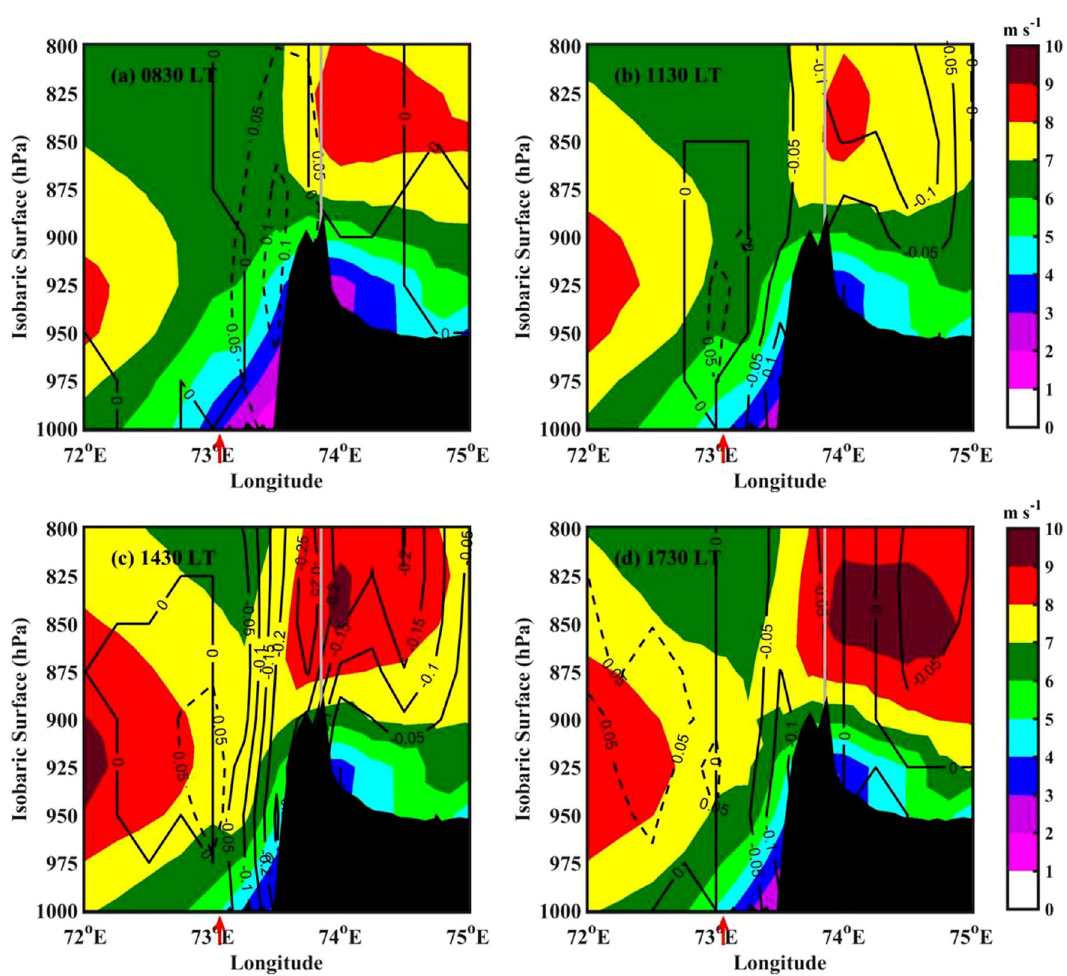
Figure 5. The mean wind speed (colour-filled contours) and vertical velocity (in pressure coordinate) deviation ◦ from the mean (black contours) along 18 N during ( a ) 0830 LT, ( b ) 1130 LT, ( c ) 1430 LT, and ( d ) 1730 LT. The solid contours represent negative vertical velocity (upward motion), and dashed contours represent positive vertical velocity (downward motion). The coastline is indicated with a red colour arrow below the X-axis. The ◦ topography along 18 N is shown by black